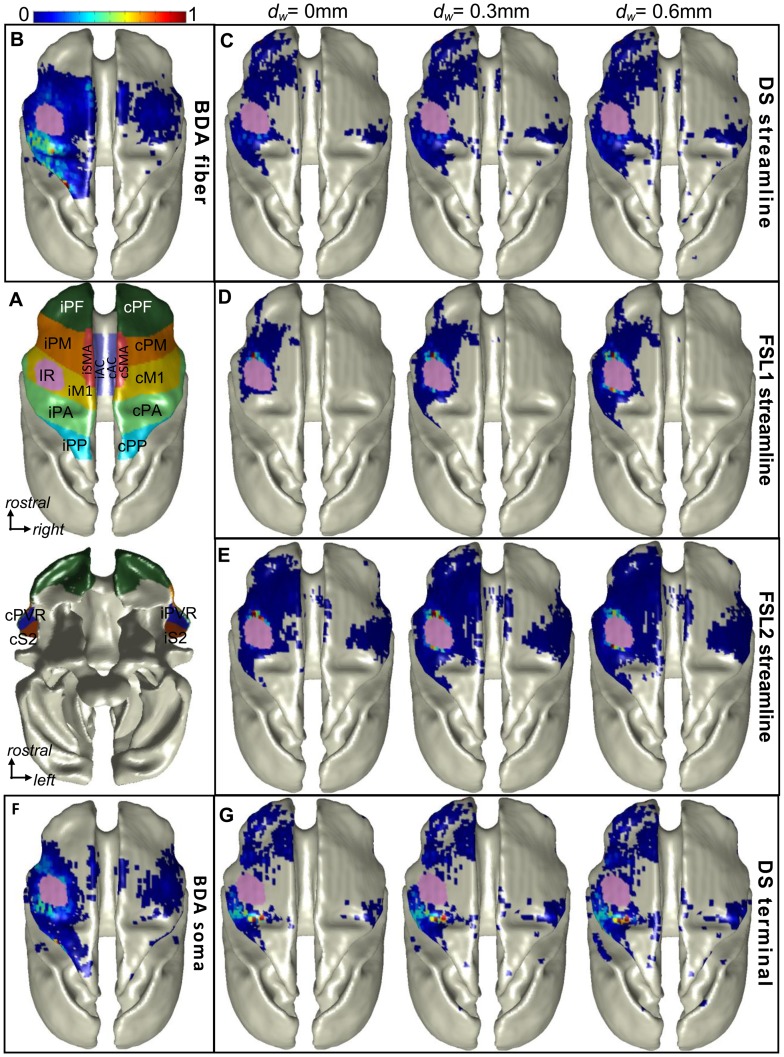
Dorsal view of 3D DDMs rendered on the WGM interface.(A) shows the territories of all the ROIs and the BDA injection region (upper-dorsal view; bottom-ventral view). (B) shows the BDA fiber DDM and (C–E) show respectively the streamline DDMs using DS, FSL1 and FSL2 tractography schemes (in rows) with different dw (in columns). (F) shows BDA soma DDM and (G) shows streamline terminal DDMs with different dw (in columns). Note that some hot spots in (B) are obscured in this view. All data are presented in Fig. 4 and the Tables.